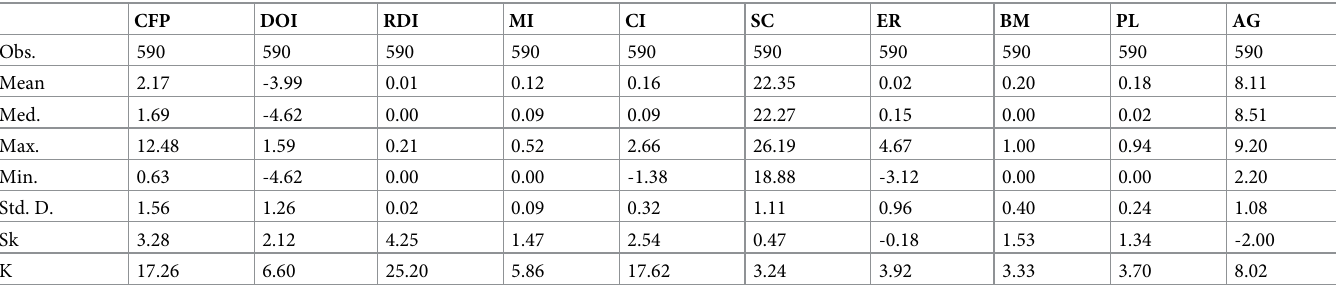
Table 2. The variable narrative statistical scale was studied. CFP DOI RDI MI